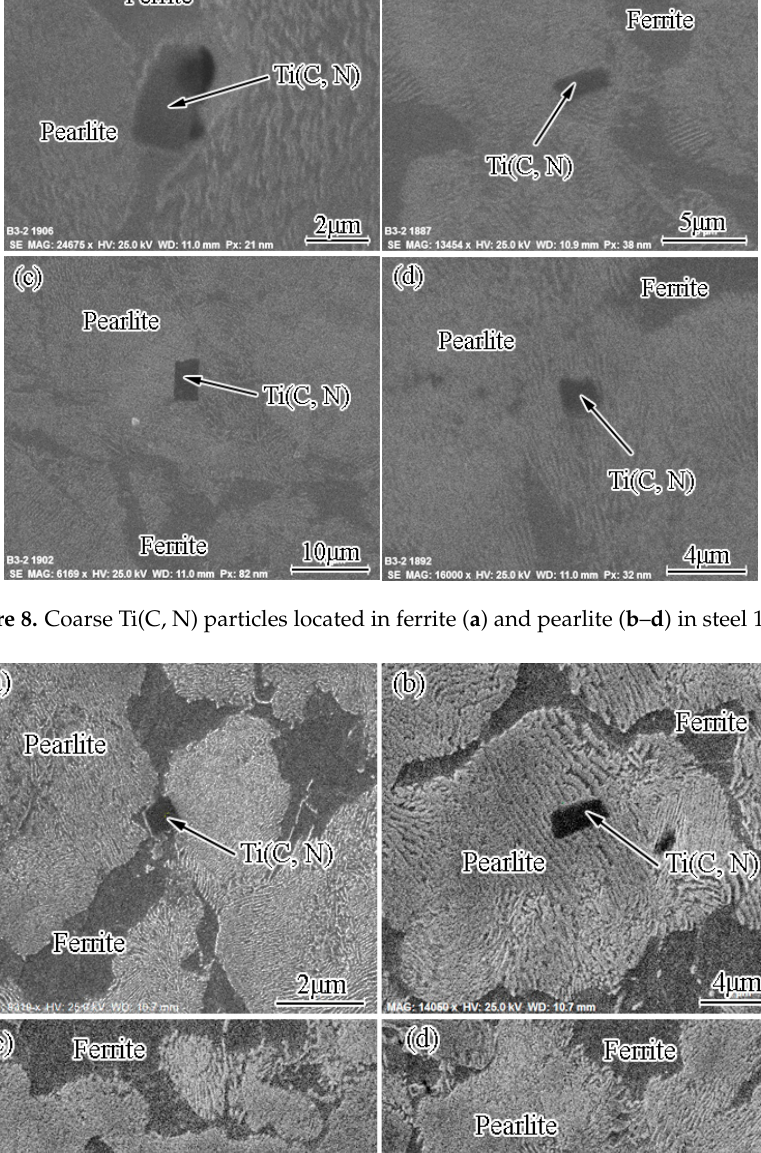
Figure 7. Coarse Ti(C, N) particles located in ferrite ( a , b ) and pearlite ( c , d ) in steel 1.